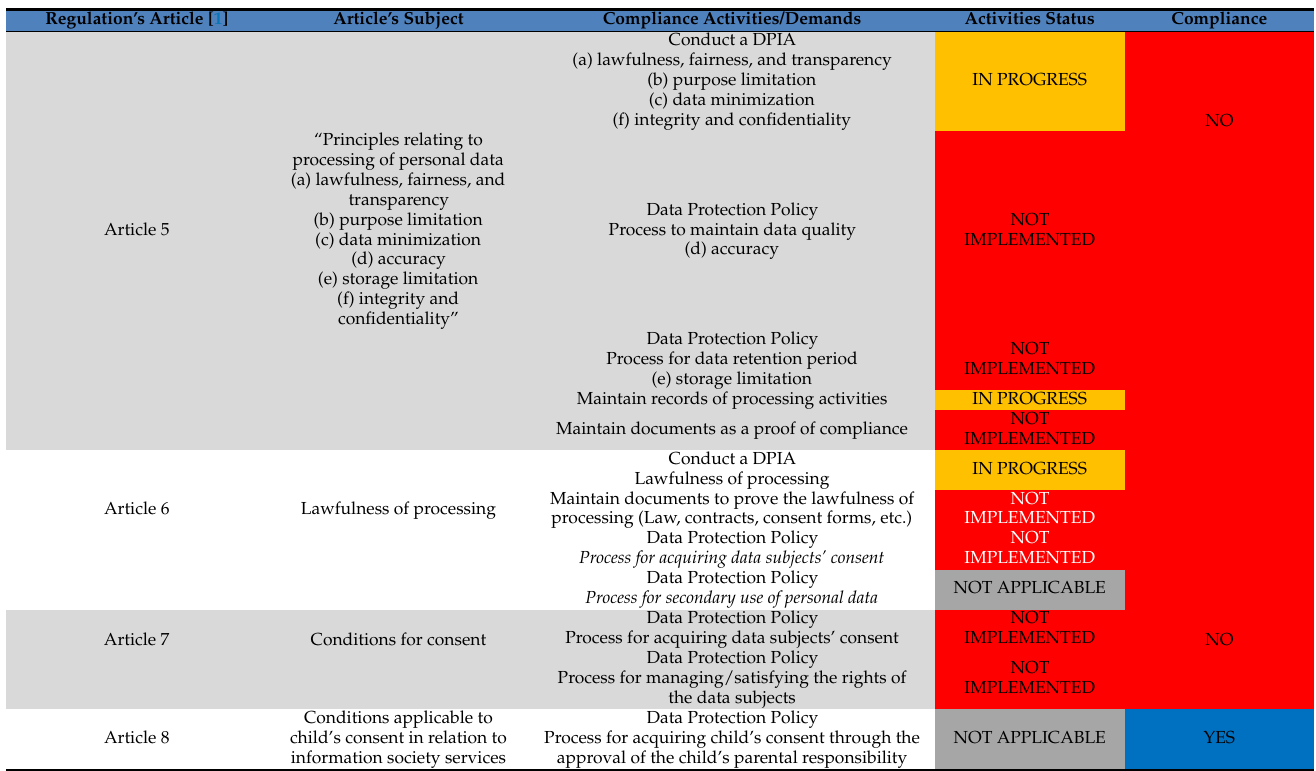
Table 6. Findings of the gap analysis for the processing activity, PP4: Provision of Patients Care-Services in relation to the requirements of the general data protection